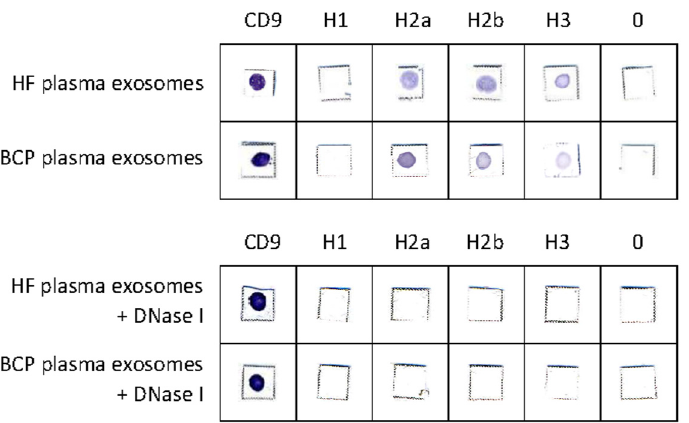
Figure 5. Dot immunoassay. The exosomes from plasma of HFs and BCPs were absorbed on a nitrocellulose membrane and incubated with antihistone or anti-CD9 antibodies and then incubated with a conjugate of goat anti-rabbit antibodies or rabbit anti-mouse antibodies conjugated with horseradish peroxidase. The antigen–antibody complexes were visualized with 4-chloro-1-naphtol. According to the obtained data, histone H1 was absent from the surface of exosomes both untreated and treated by nuclease. Moreover, the presence of CD9 and the disappearance of H2a, H2b, and H3 histones after treatment with DNase I indicate that these histones are not part of the exosomal membrane, but are part of the cirDNA–protein